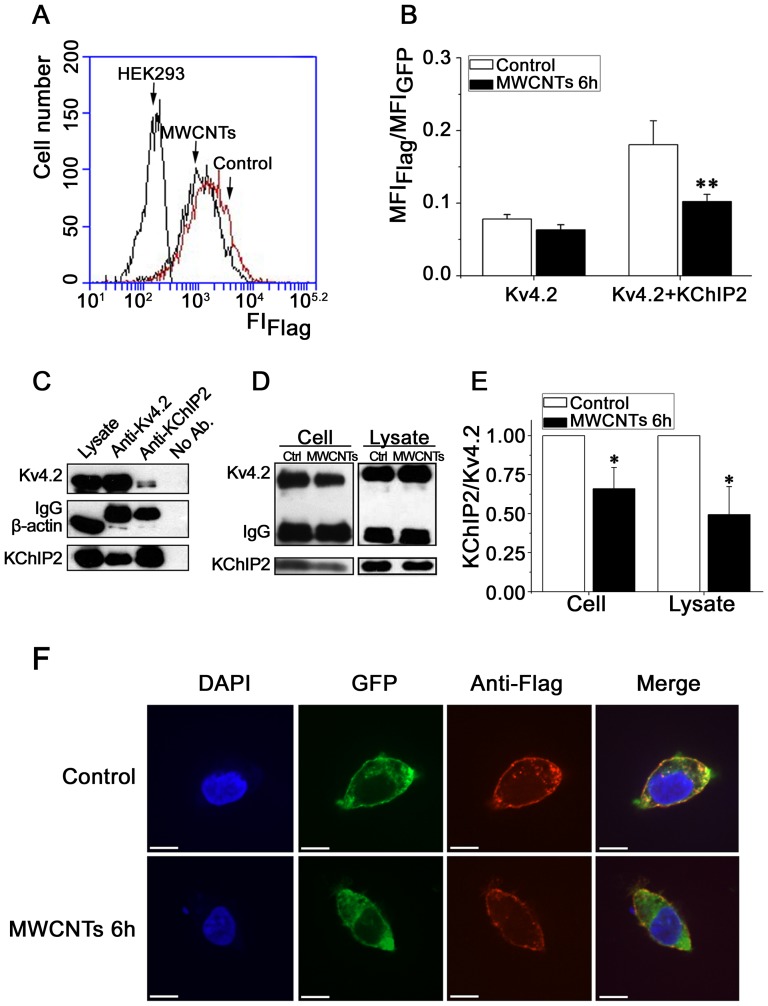
Effects of MWCNTs on Kv4.2 trafficking in HEK293 cells.
A, an original recording of flow cytometry showing the fluorescence of Flag which represented the population of Kv4.2 in cell membrane. A leftward shift of the trace meant a reduction of fluorescence intensity in membrane and vise versa. Untransfected HEK293 cells served as negative control. B, ratio of mean fluorescence intensity of Flag to GFP in HEK293 cells expressing Kv4.2 with or without KChIP2 upon MWCNTs treatment from Figure 7A. C, aliquots of cell lysate from HEK293 cells expressing Kv4.2 and KChIP2 were mixed with either anti-Kv4.2 antibody or anti-KChIP2 antibody and precipitated with protein A-sepharose. Immune complexes were resolved by SDS-PAGE. The immunoprecipitating antibodies were indicated above each lane, and detecting antibodies were shown at the left side. D, effects of MWCNTs treatment on the ratio of KChIP2 to Kv4.2 with anti-Kv4.2 antibody as bait for co-IP in HEK293 cells and cell lysate. MWCNTs were applied to the culture medium and cell lysate for 6 h, respectively. E, statistical results of the effects of MWCNTs on the ratio of KChIP2 to Kv4.2 in HEK293 cells expressing Kv4.2 and KChIP2. * P<0.05, ** P<0.01 vs. control. F, confocal images showing the membranous and intracellular distributions of Kv4.2. GFP (green) and anti-Flag (red) represented the total and membranous Kv4.2, respectively. Note that MWCNT-treated cells showed reduced membranous Kv4.2 compared with control cells. Scale bars  =  50 µm.